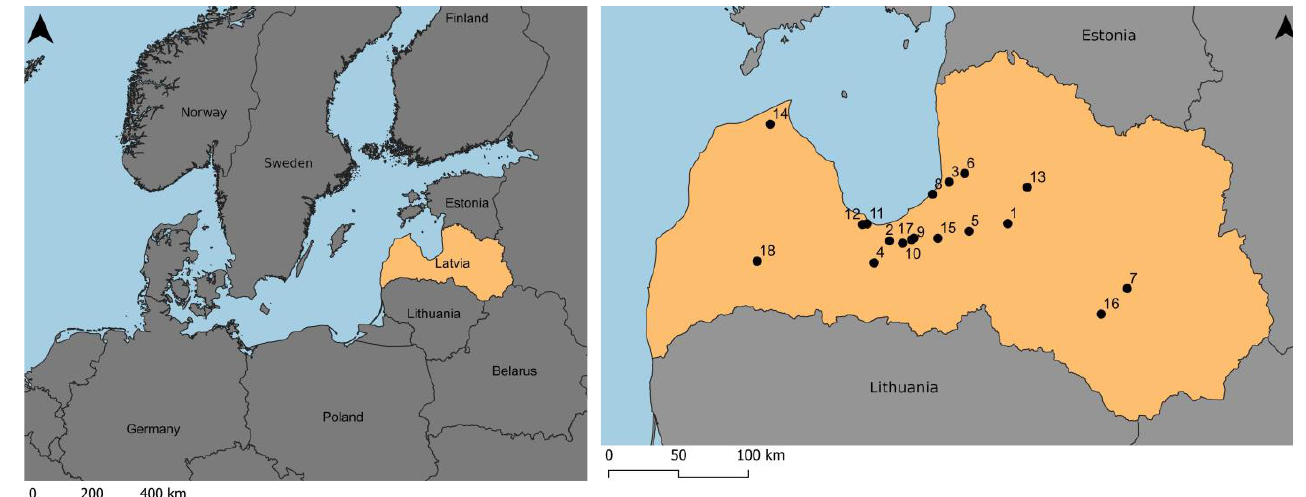
Figure 5. Location of cloudberry study area in Latvia. Study sites: 1 — Berzu Bog, 2 — Cena Moorland,